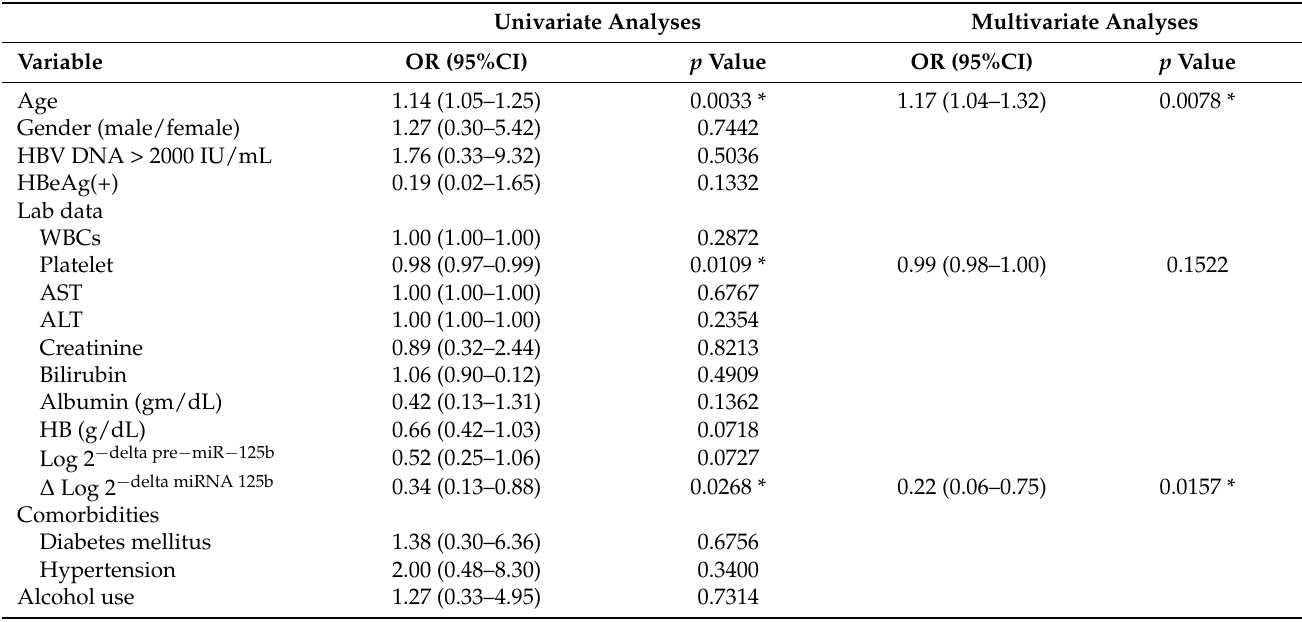
Table 3. Baseline vs. 12M FIB-4 index analysis in ETV ( n = 59). Univariate Analyses Multivariate Analyses